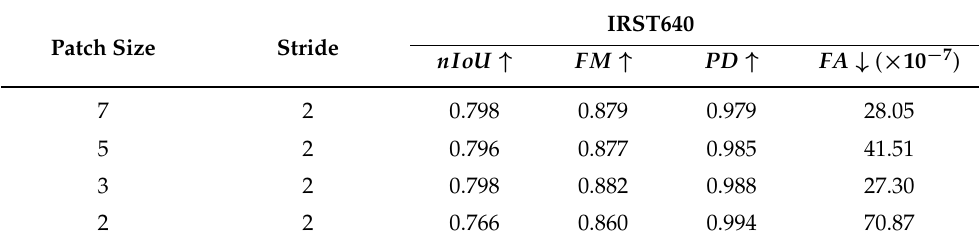
Table 5. Results of different parameters in the OSPE on the IRST640 dataset.